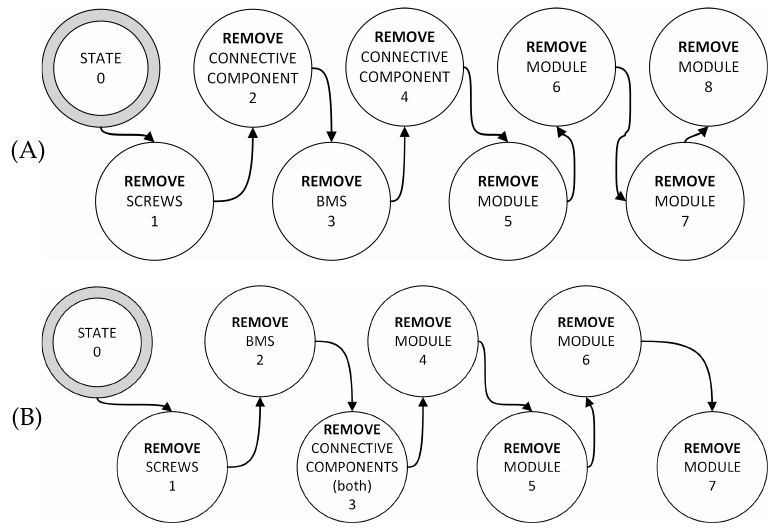
Figure 12. Dismantling plans (A) or (B) proposed by the task planner